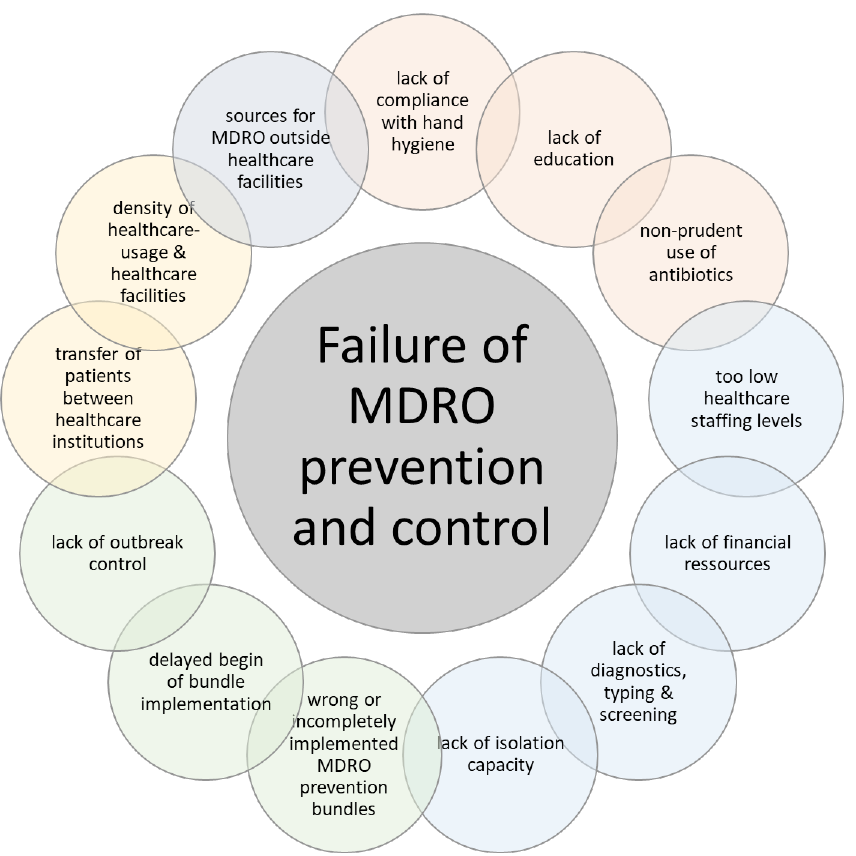
Figure 1. Typical reasons for the failure of infection and control of multidrug-resistant microorganisms (MDRO).